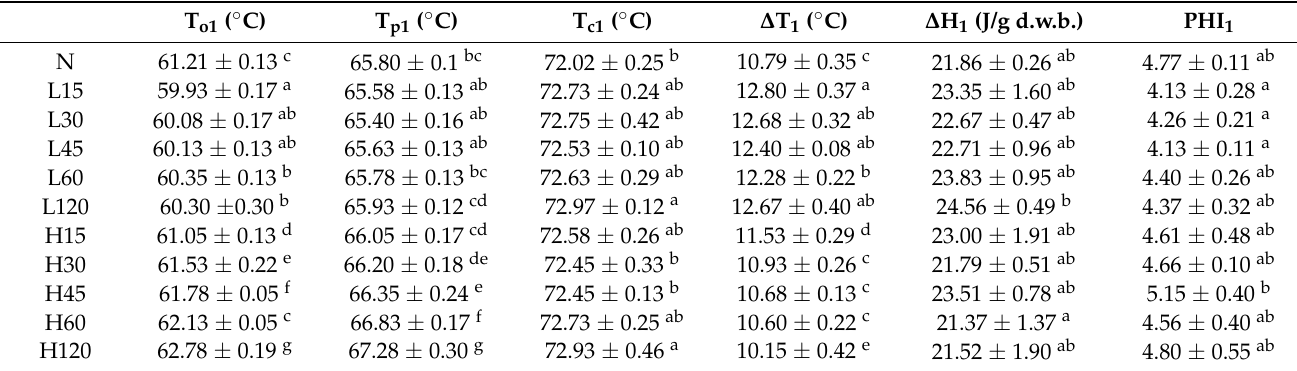
Values followed by the same letters in the same column are not significantly different at α < 0.05. During modification, starch is mixed in an aqueous medium, which may cause the partial disordering of its structure (combined with the hydrolysis of some phosphate groups), which will be counteracted by the cross-linking effect. Since the melting point of starch crystallites is influenced by the surrounding amorphous regions, an earlier start of gelatinization (T o1 ) in the L-starches (compared to the N-starch) indicates the loosening of the structure during phosphorylation. In the case of H-starches, the gradually increased cross-linking (along with the extension of the modification time) ensured a protective effect. As the gelatinization temperatures (such as T o1 and T p1 ) reflect the structure or- dering degree in the starch granules, it may be assumed that the H-starches were harder. As suggested by Gunaratne and Hoover [43], the difference in the ∆ T values of the starches indicates the various heterogeneity of the crystallites within L- and H-starches. The modification conditions did not affect the conclusion of gelatinization; there- fore, the gelatinization range decreased. The gelatinization enthalpy of the native starch